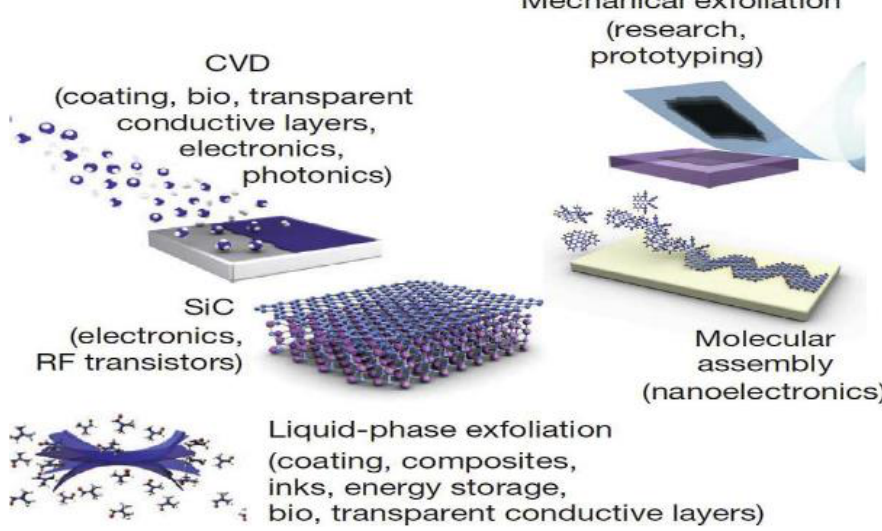
Figure 1. The five graphene and graphene derivative production mechanisms according to specific requirements and intended applications. Reprinted with permission from Ref.[8].